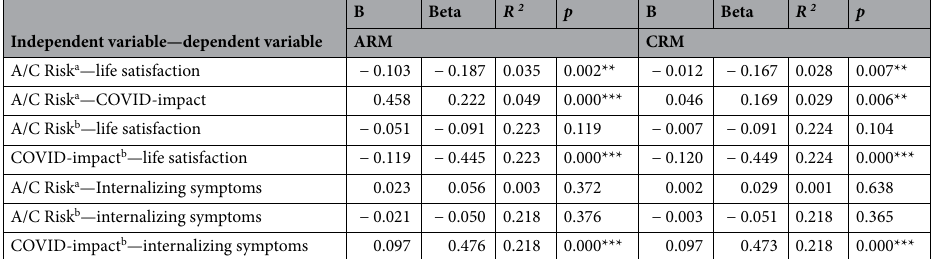
Table 3. Unstandardized (B) and Standardized beta (β) Regression Coefficients, R Squared (R 2 ), Significance (p) for all predictors in mediation analysis through separate and hierarchical Regression Models. Asterisks signify significant effects, * p < 0.05, ** p < 0.01 & *** p < 0.001. a In a separate regression model. b In a hierarchical regression model, R 2 of the (combined) hierarchical